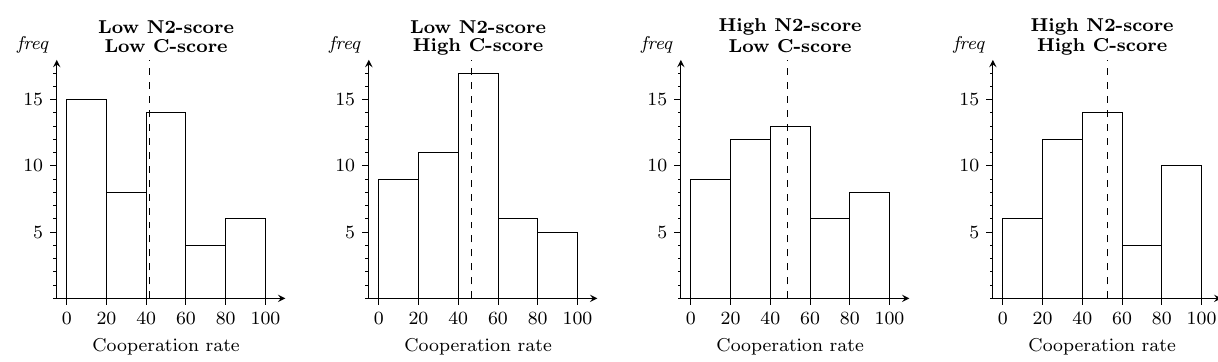
Low N2-score Low C-score